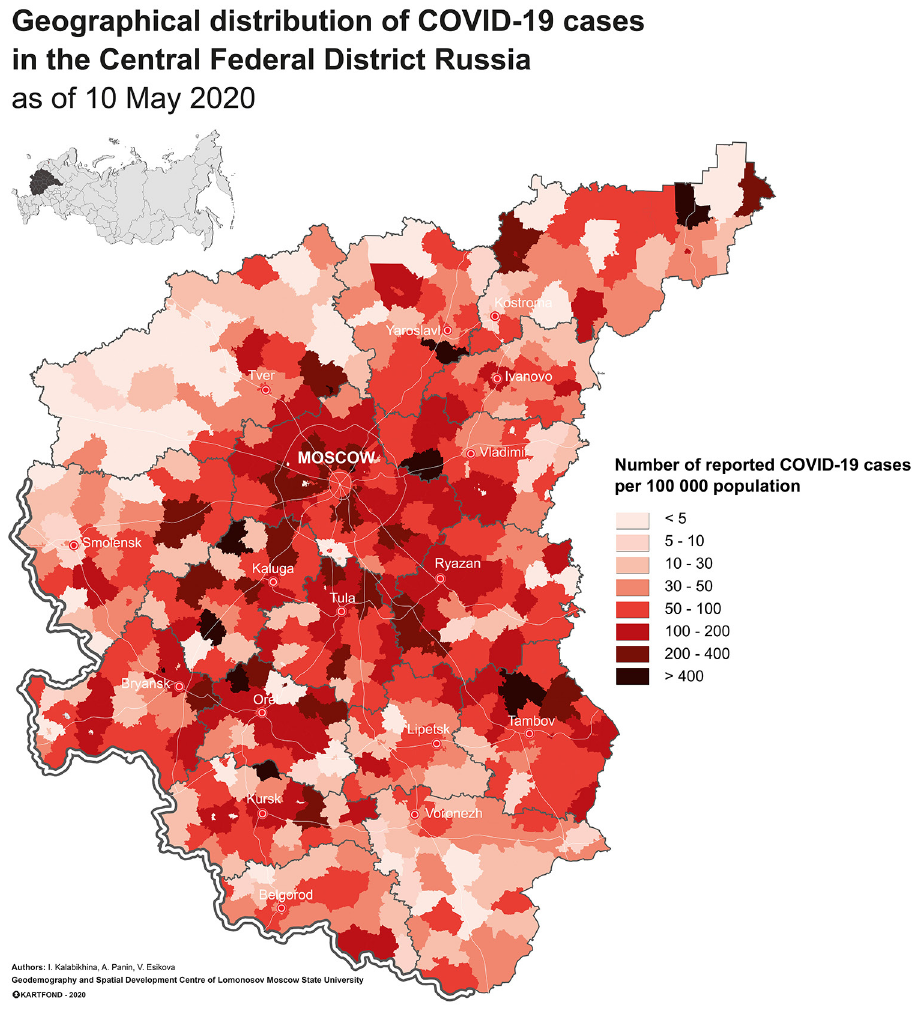
Figure 16. Geographical distribution of COVID­19 cases in the municipalities of the Central Federal District of Russia, number of reported COVID­19 cases per 100 thousand population, 10.05.2020, ac­ cording to Rospotrebnadzor (2020). Source: Compiled by the researchers of the Geodemography and Spatial Development Centre of the Population Department of the Economics Faculty of Lomonosov Moscow State University together with the “Kartfond” research